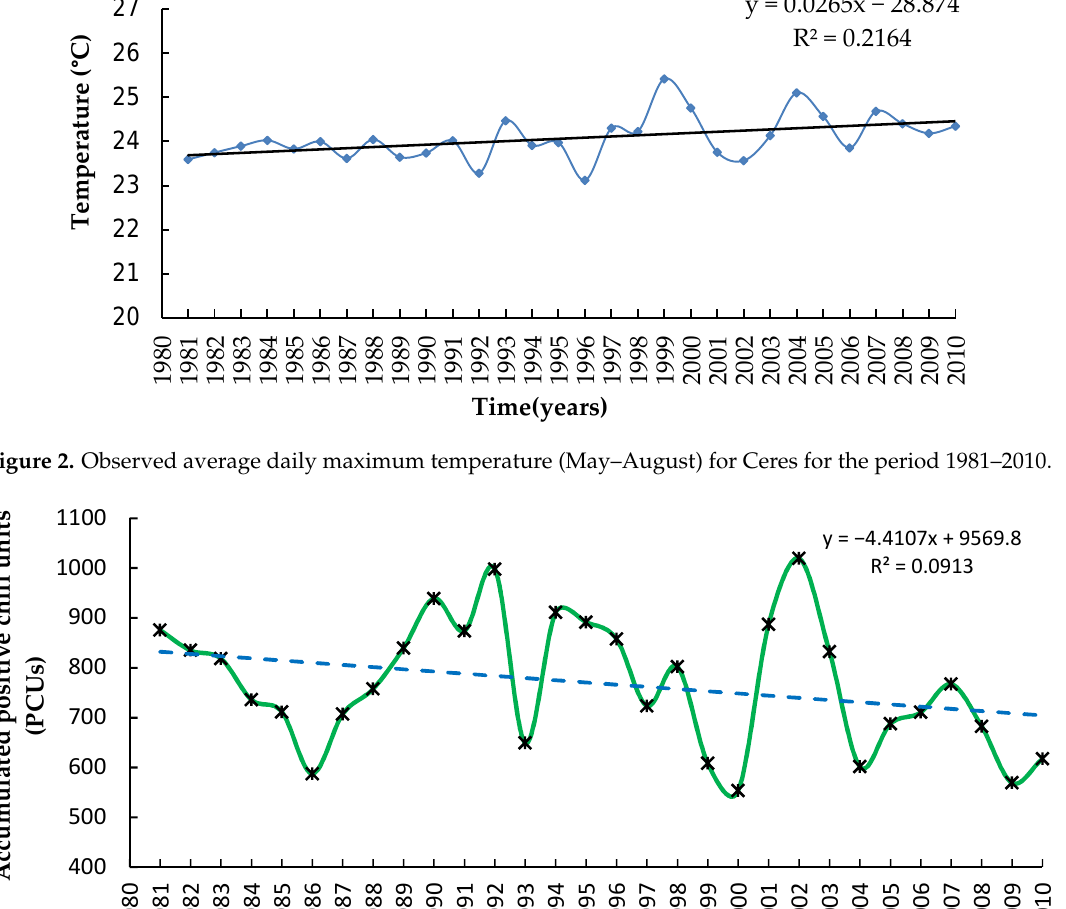
Figure 2. Observed average daily maximum temperature (May–August) for Ceres for the period 1981–2010.